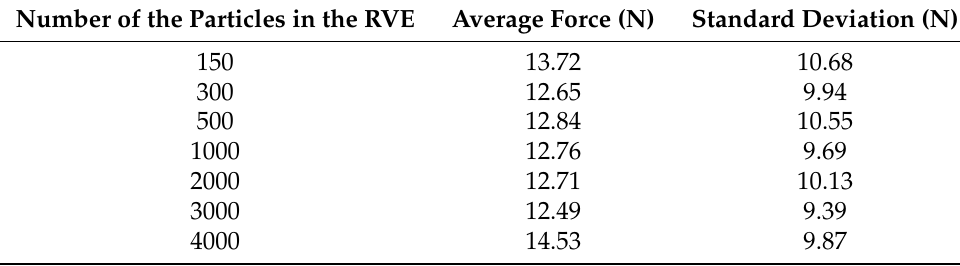
Table 2. The average of inter-particle forces and their standard deviation for the different size of the representative volume elements (RVEs)